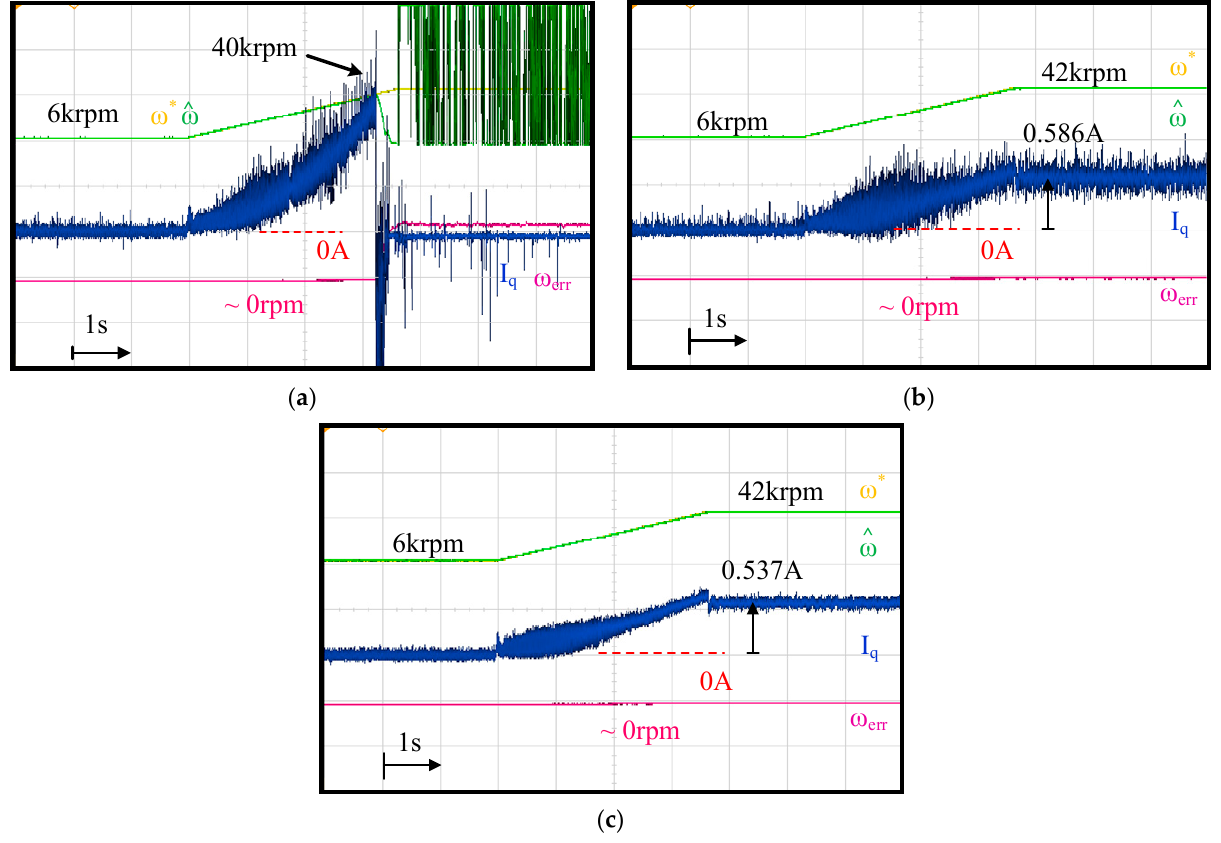
Figure 15. Comparison of current regulation using ( a ) inverter current I Ldq , ( b ) estimated machine current ˆI dq with direct estimation in (14) and ( c ) estimated machine current ˆI dq with proposed observer-based estimation in Figure 6.